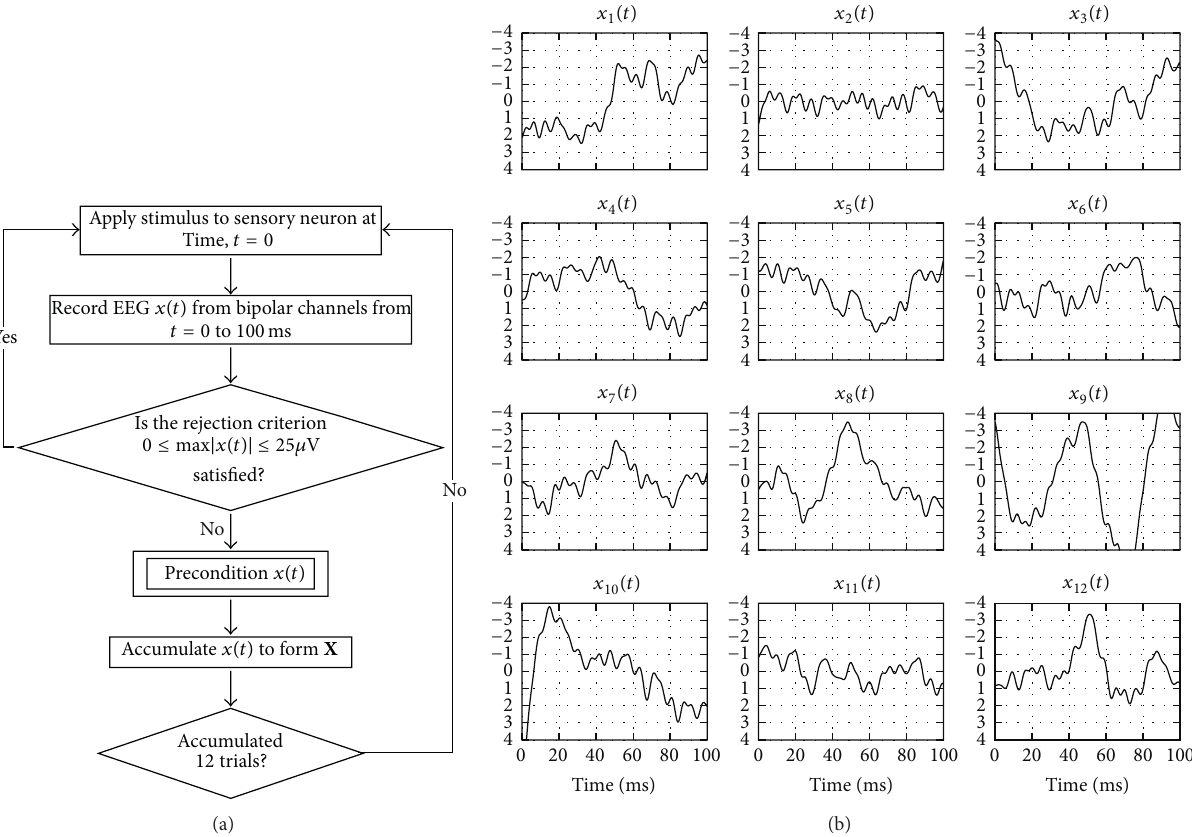
Figure 1: Diagram for “data acquisition” inclusive of the rejection criterion: (a) algorithm flowchart for data acquisition; (b) one such resulting matrix consisting of 12 satisfactory trials for patient 8 from Table